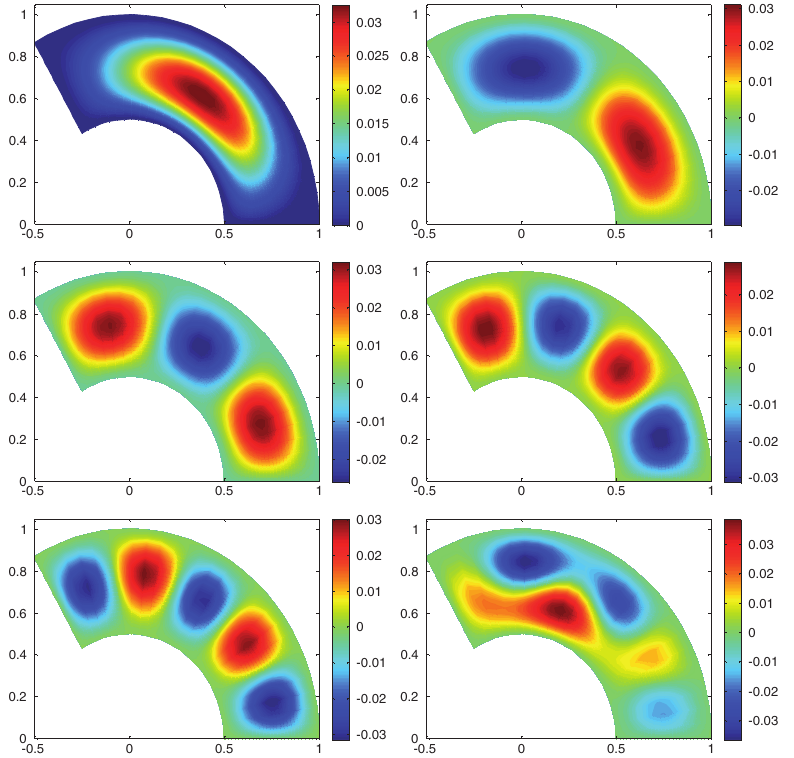
Figure 14 The first six mode shapes of a fully clamped orthotropic FGM annular sector plate for n = 0.1 and θ = 120 °